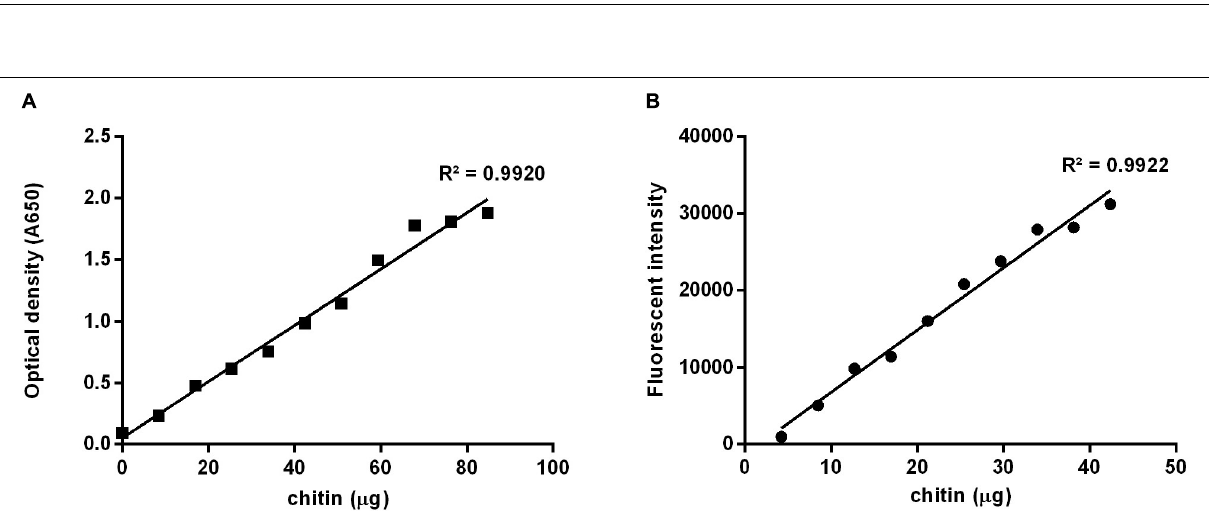
Frontiers in Physiology |